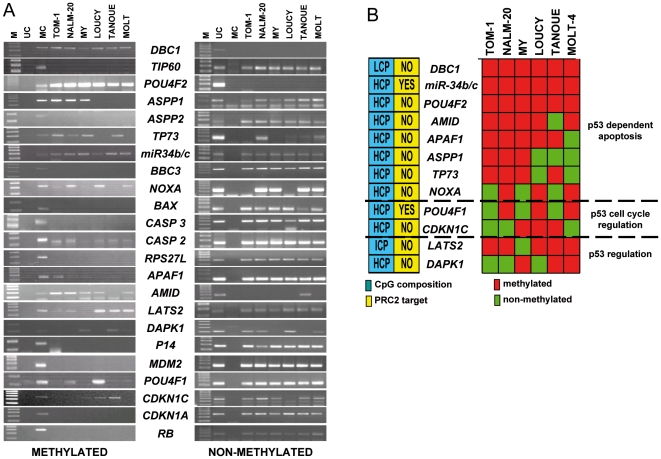

TP53 pathway genes are methylated in ALL cell lines.
A. MSP analysis of the methylated and un-methylated sequences of genes implicated in TP53 pathway in ALL derived cell lines. UC: un-methylated control (DNA of peripheral blood from a healthy donor). MC: universally methylated control, M: 100 bp molecular marker. B. Graphic representation of the results of methylation of genes of TP53 pathway and its involvement in TP53 dependent apoptosis, cell cycle or regulation of TP53. Information regarding CpG composition and whether these genes are target of PCR2 in ESC is shown. Red: methylated, Green: unmethylated.